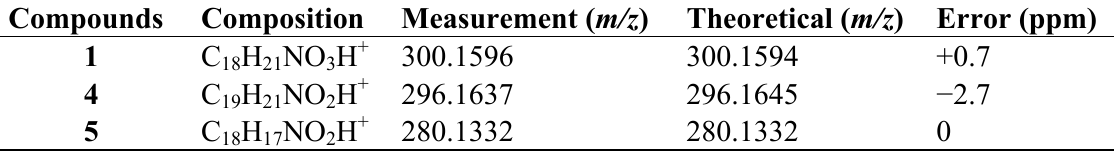
Table 2. Accurate masses and assigned elemental compositions of 1 , 4 and 5 .